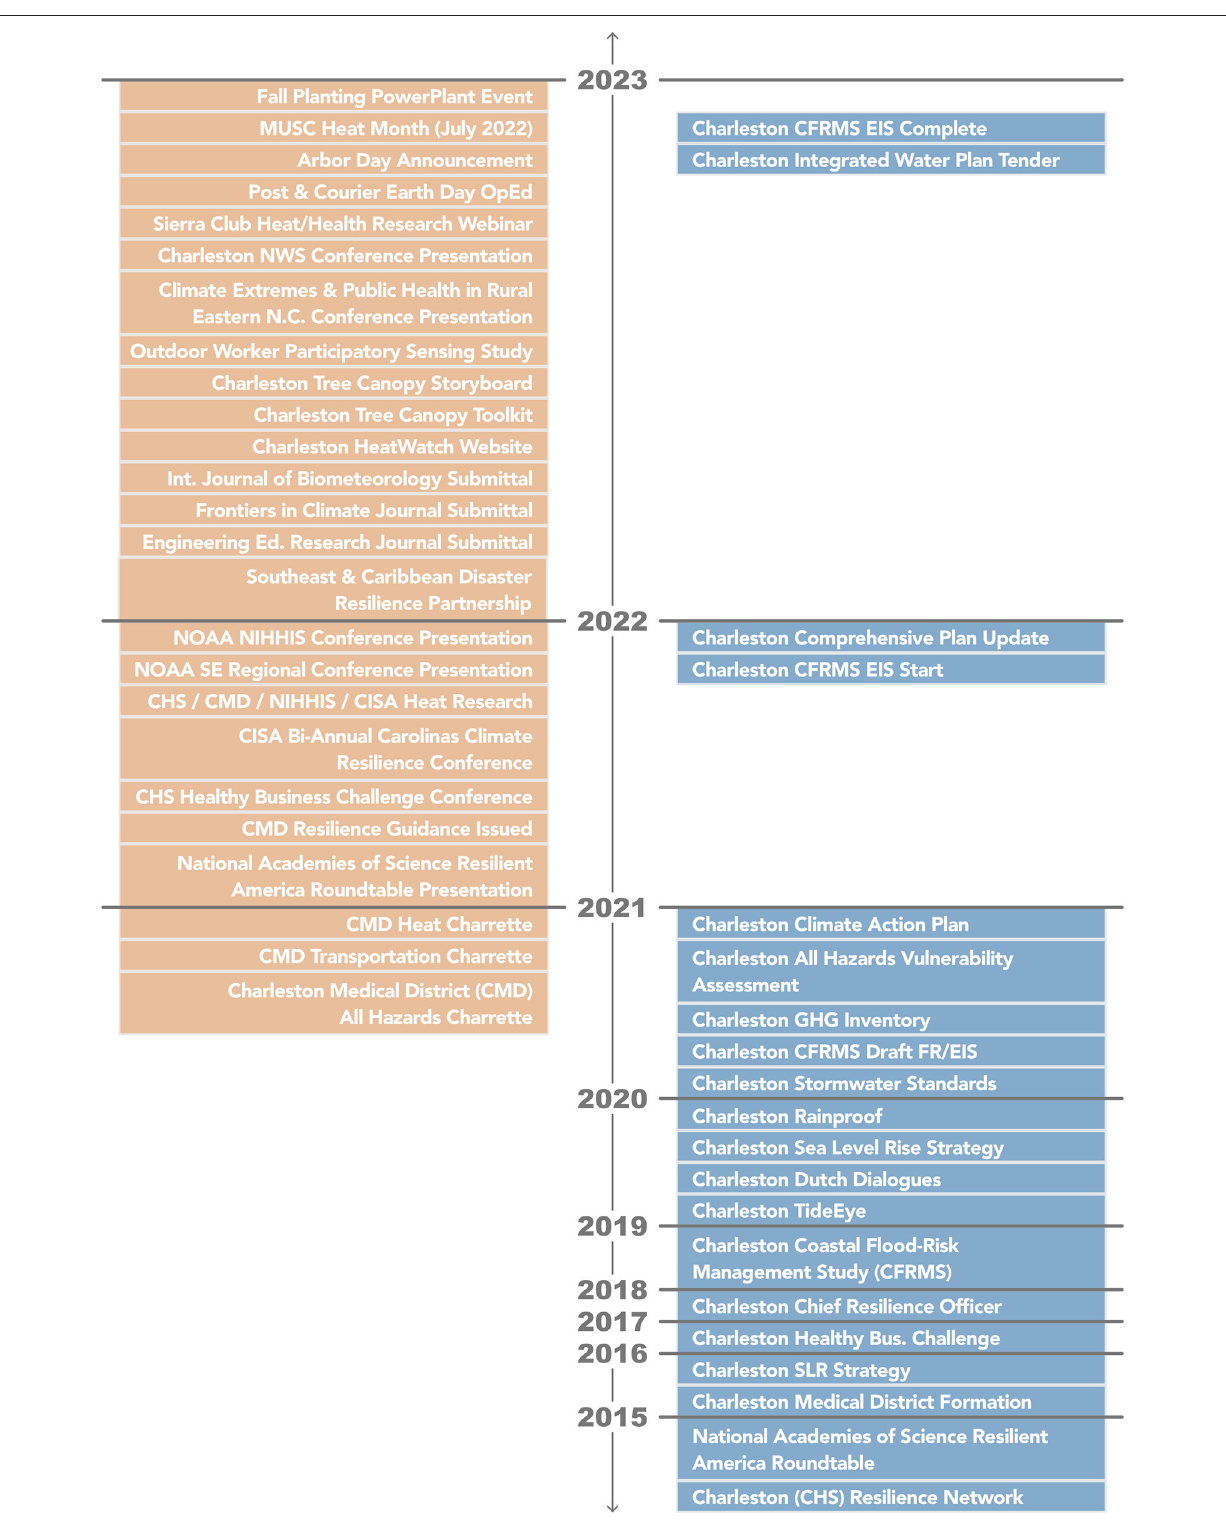
FIGURE 4 | Timeline of key programmatic